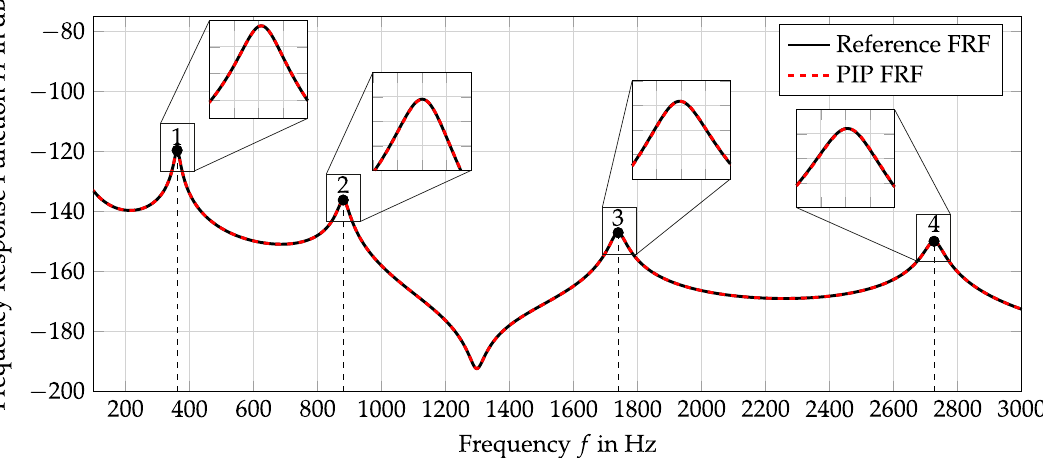
Figure 7. Comparison of the reference FRF curve and the FRF curve estimated by the PIP.